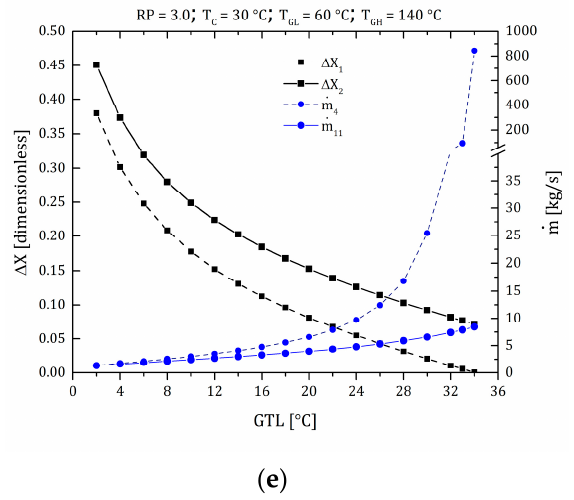
Figure 3. Concentration gradients and mass flow ratio of the MAHP. ( a ) Case study: RP = 1.3, T C = 30 °C, T GL = 60 °C, T GH = 140 °C; ( b ) T GH effect; ( c ) T C effect; ( d ) T GL effect; ( e ) RPT GH effect.